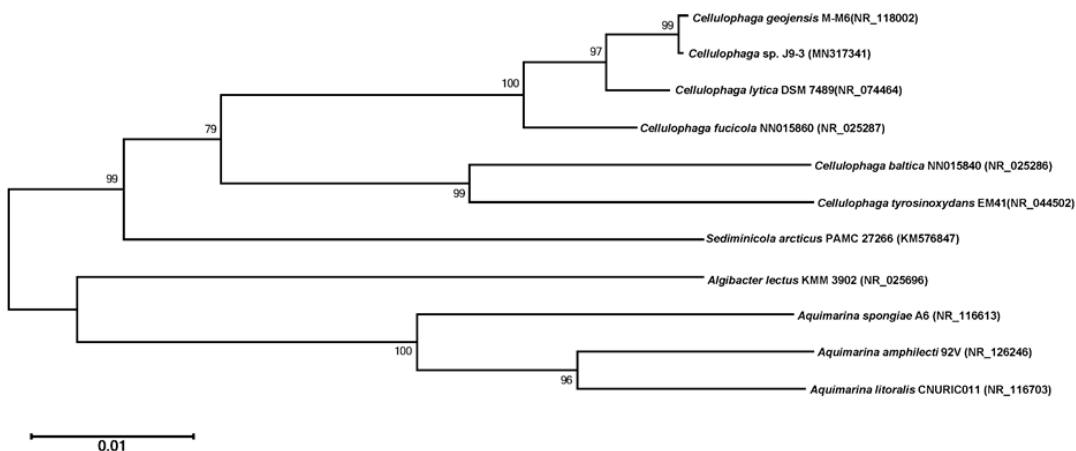
Figure 2. Neighbor-joining phylogenic tree based on 16S rRNA gene sequences between strain J9-3 and other species. Nucleotide sequence accession numbers are given in parentheses. Scale bar, 0.01 substitutions per 100 nucleotides.